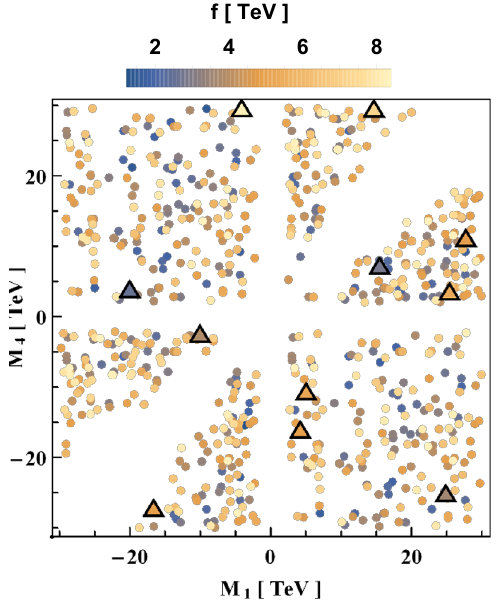
Figure 19 . High scale scan of the MCHM 14 parameter space, including the benchmark points of ta- ble 8 represented by triangles and the points satisfying the constraint in eq. 5.1. The compositeness scale f is color